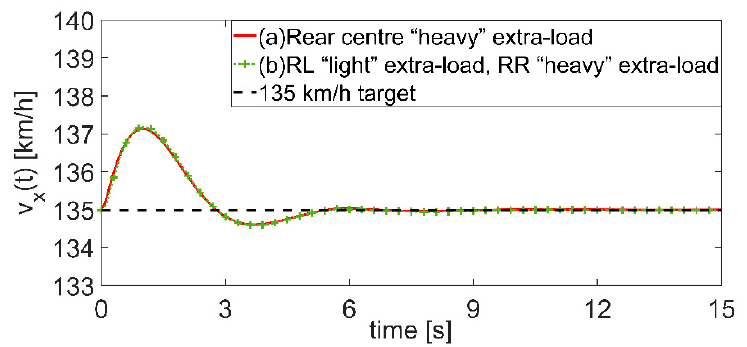
Figure 19. SV Equalization: speed tracking.